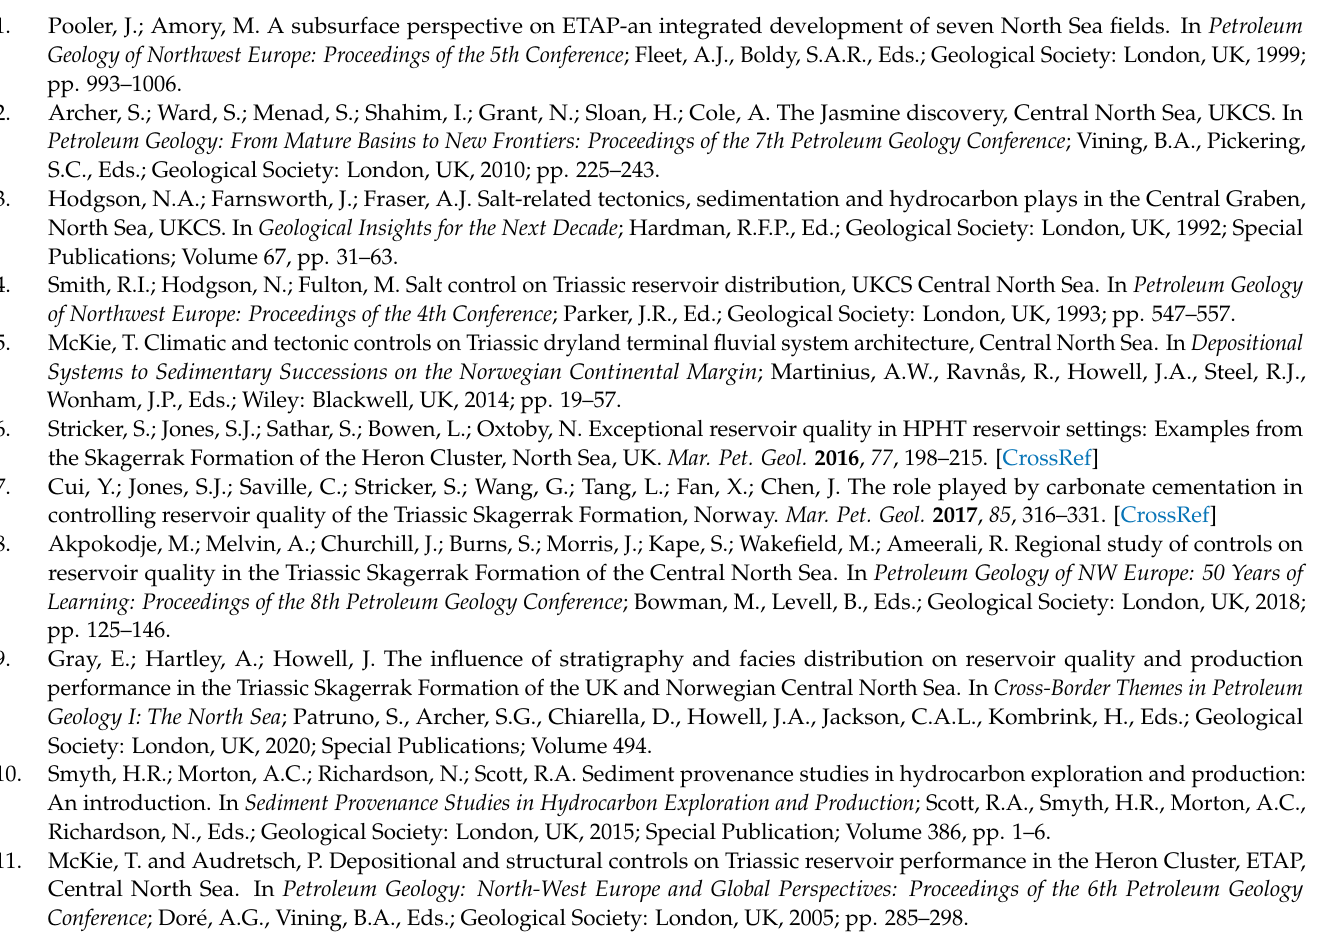
Pb data. Table S2: Culzean-Marnock apatite U-Pb data cPb uncorrected. Table S3: